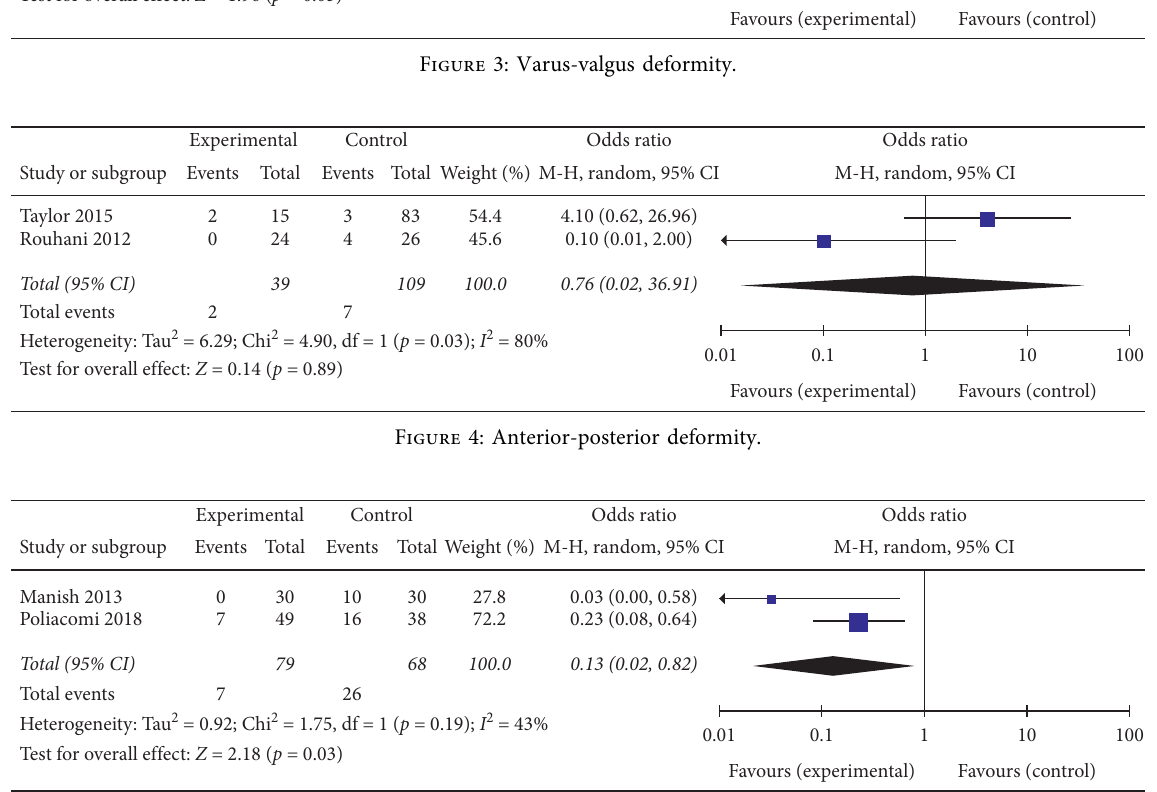
Figure 5: Rotational